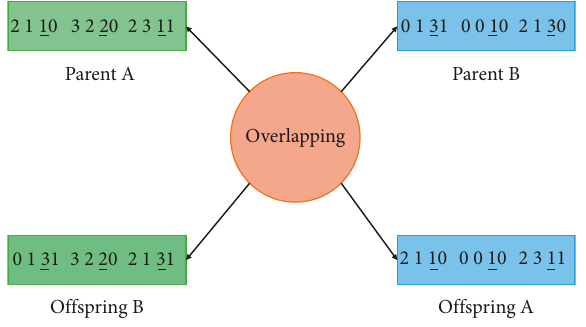
Figure 3: Example of crossover algorithm. Table 1: Comparison of algorithm evaluation times.